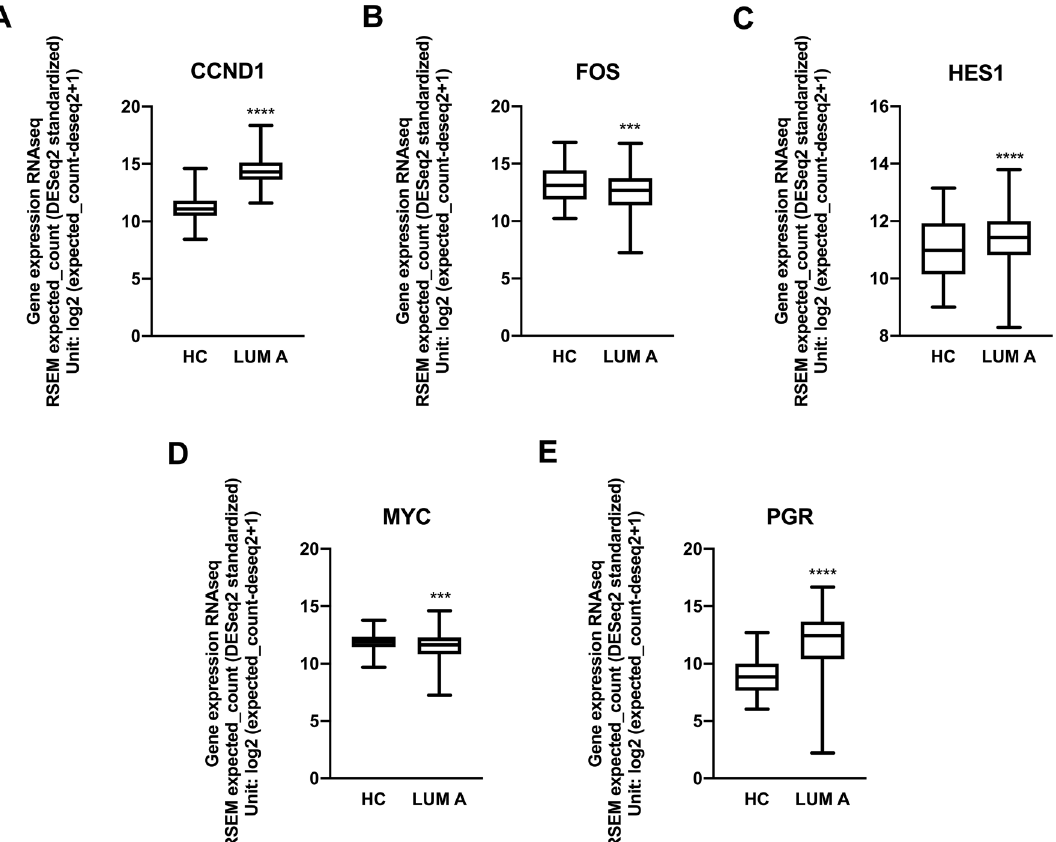
Figure 7. mRNA expression from TCGA-BC and GTEX datasets confirmed increased expression of NRIP1 target genes. Box plot analysis of the NRIP1 target genes CCND1, FOS , HES1, MYC and PGR from the GTCGA-BC/GTEX dataset. The mRNA levels of CCND1 ( A ) , HES1 ( C ) , MYC ( D ) and PGR ( E ) were increased in the luminal A patients, thus corroborating the RT-PCR results, while the mRNA levels of FOS ( B ) were decreased. The bars indicate the mean mRNA levels (± standard deviation). ***p < 0.001, ****p <